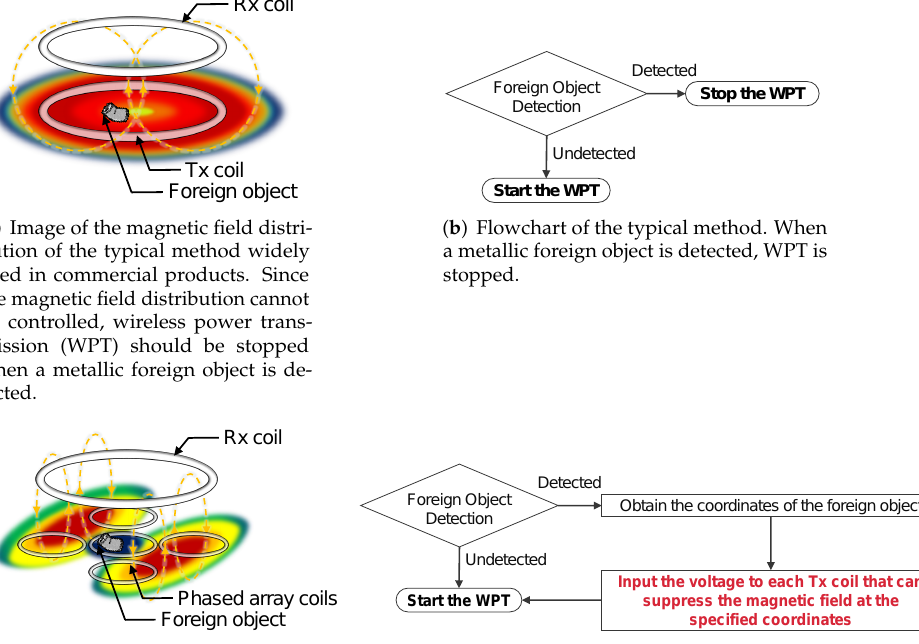
Figure 1. Simplified image of magnetic field distribution and